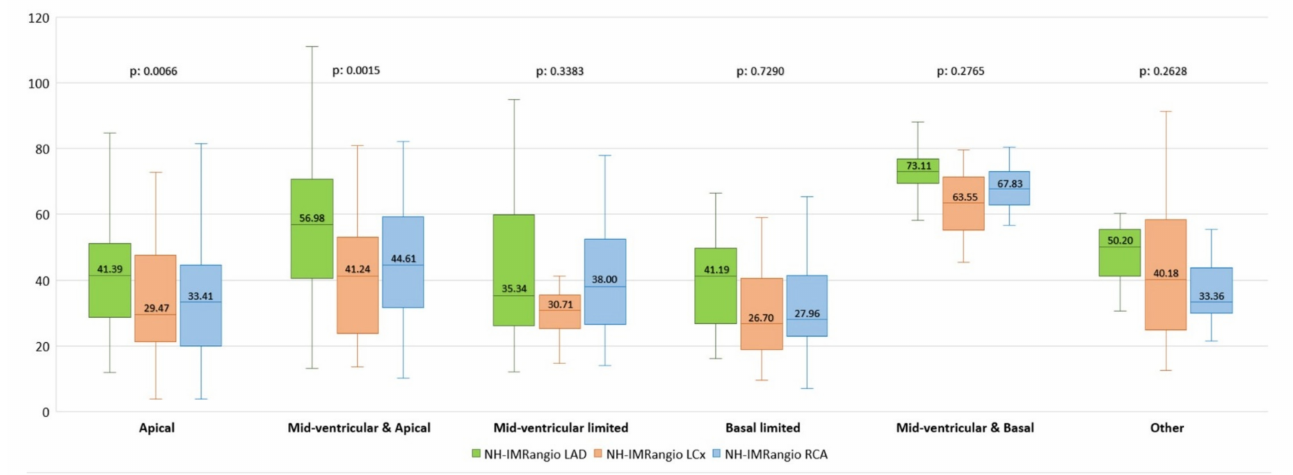
Figure 3. NH-IMRangio in the different wall abnormalities motility pattern in patients with Takotsubo syndrome (TTS). NH-IMRangio: non-hyperaemic angiography-derived index of microcirculatory resistance; LAD: left anterior descending; LCx: left circumflex artery; RCA: right coronary